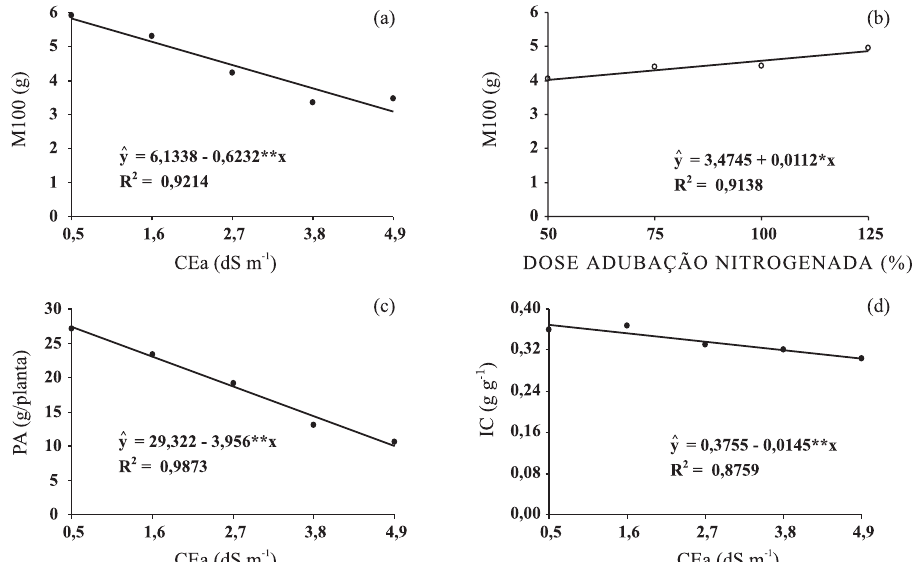
Figura 2. Massa de 100 aquênios – M100, em função da condutividade elétrica da água de irrigação (CEa) (a) e de doses de adubação nitrogenada (b), produção de aquênios por planta - PA (c) e índice de colheita - IC (d) de girassol, em função da